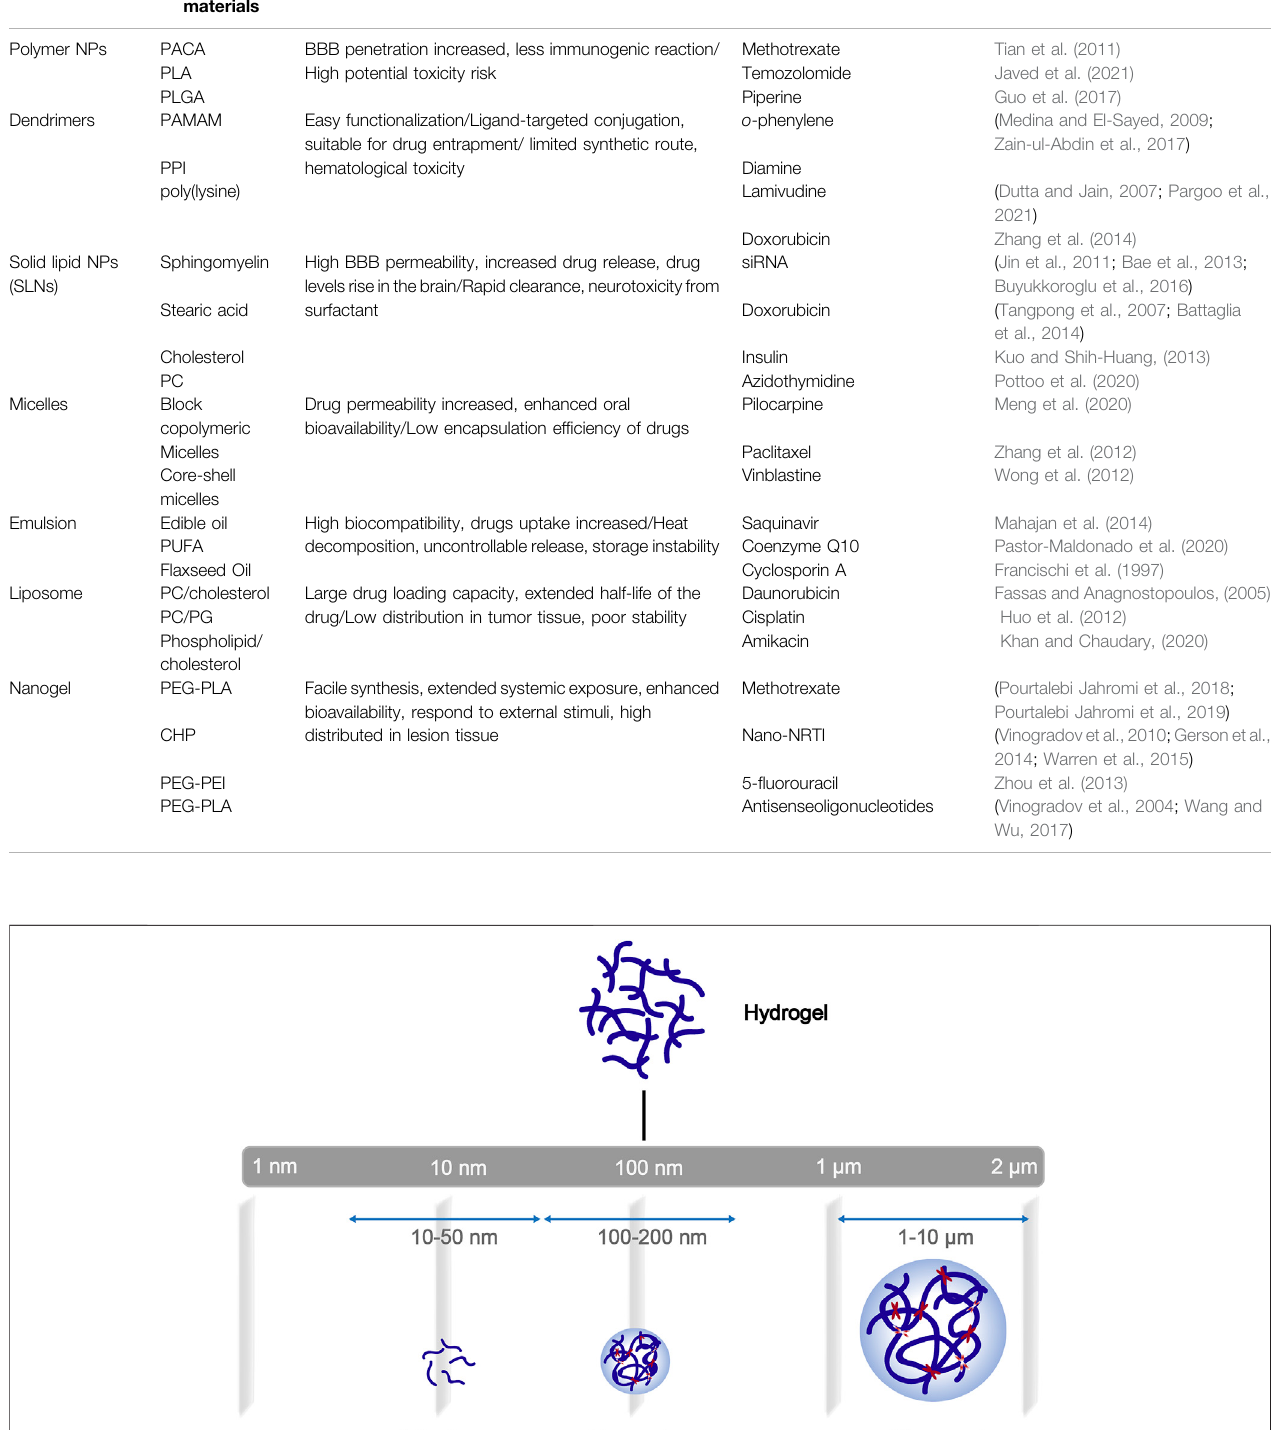
Frontiers in Bioengineering and Biotechnology |